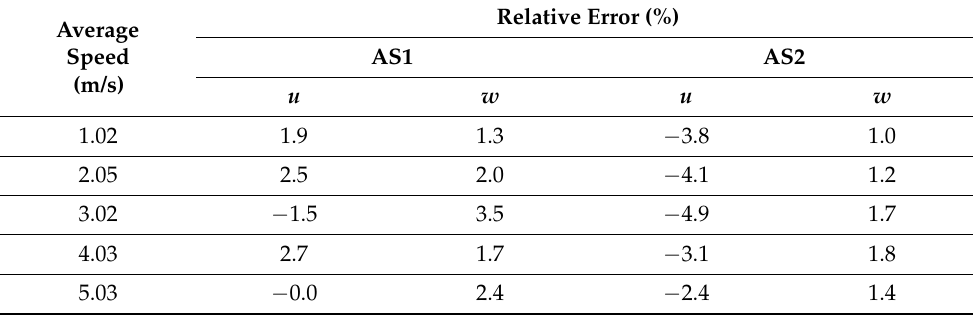
Table 3. Identified spacing errors using the VCG method.